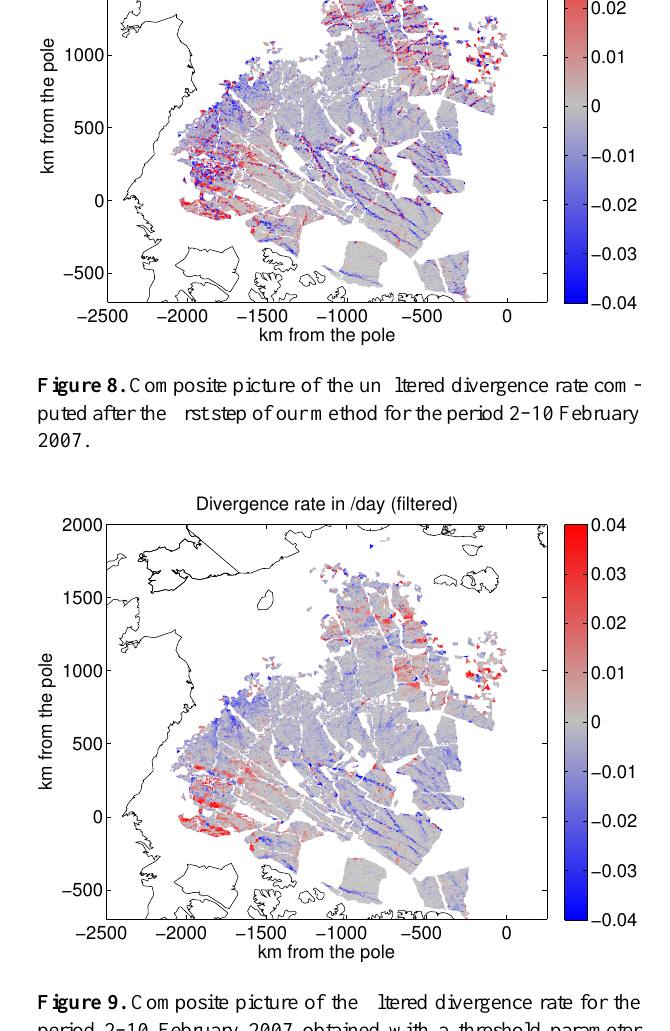
Figure 9. Composite picture of the filtered divergence rate for the period 2–10 February 2007 obtained with a threshold parameter equal to 0.02 per day and with the parameter n equal to